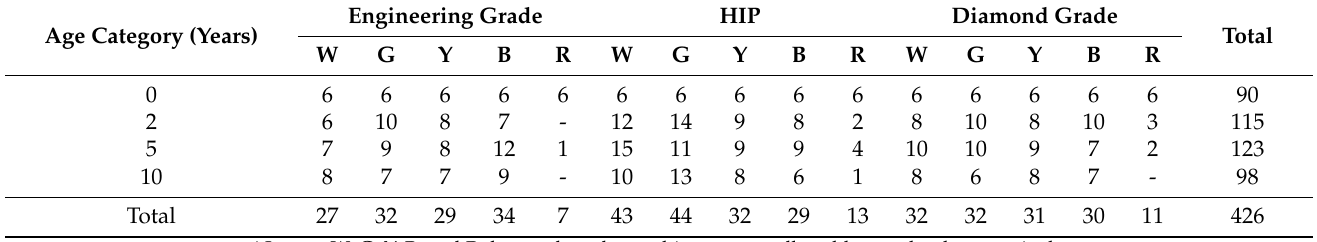
Table 2. Distribution of surveyed sign samples by age, type, and color ∗ .